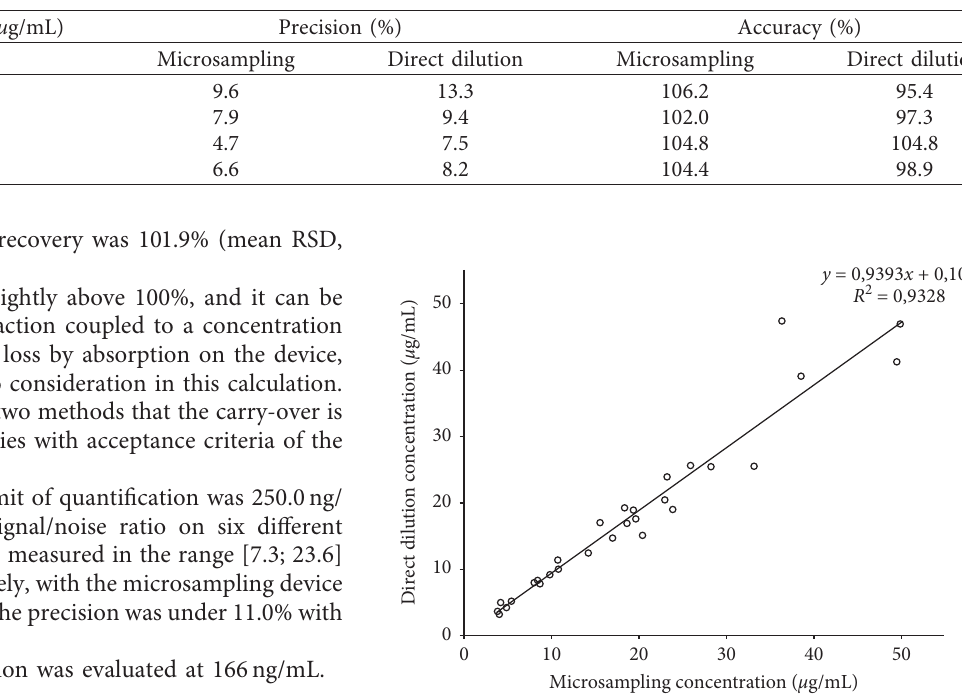
Table 3: Precision and accuracy of the microsampling and direct dilution methods ( n � 12).